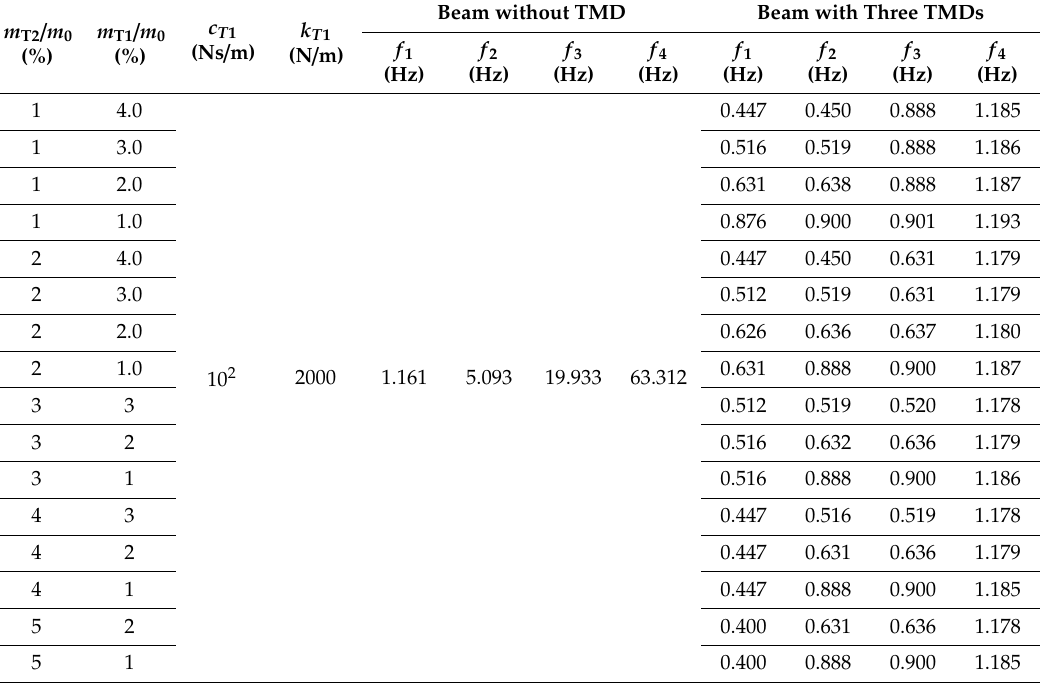
Table 4. Variation of the first natural frequencies as a function of m T2 / m 0 and m T1 / m 0 .